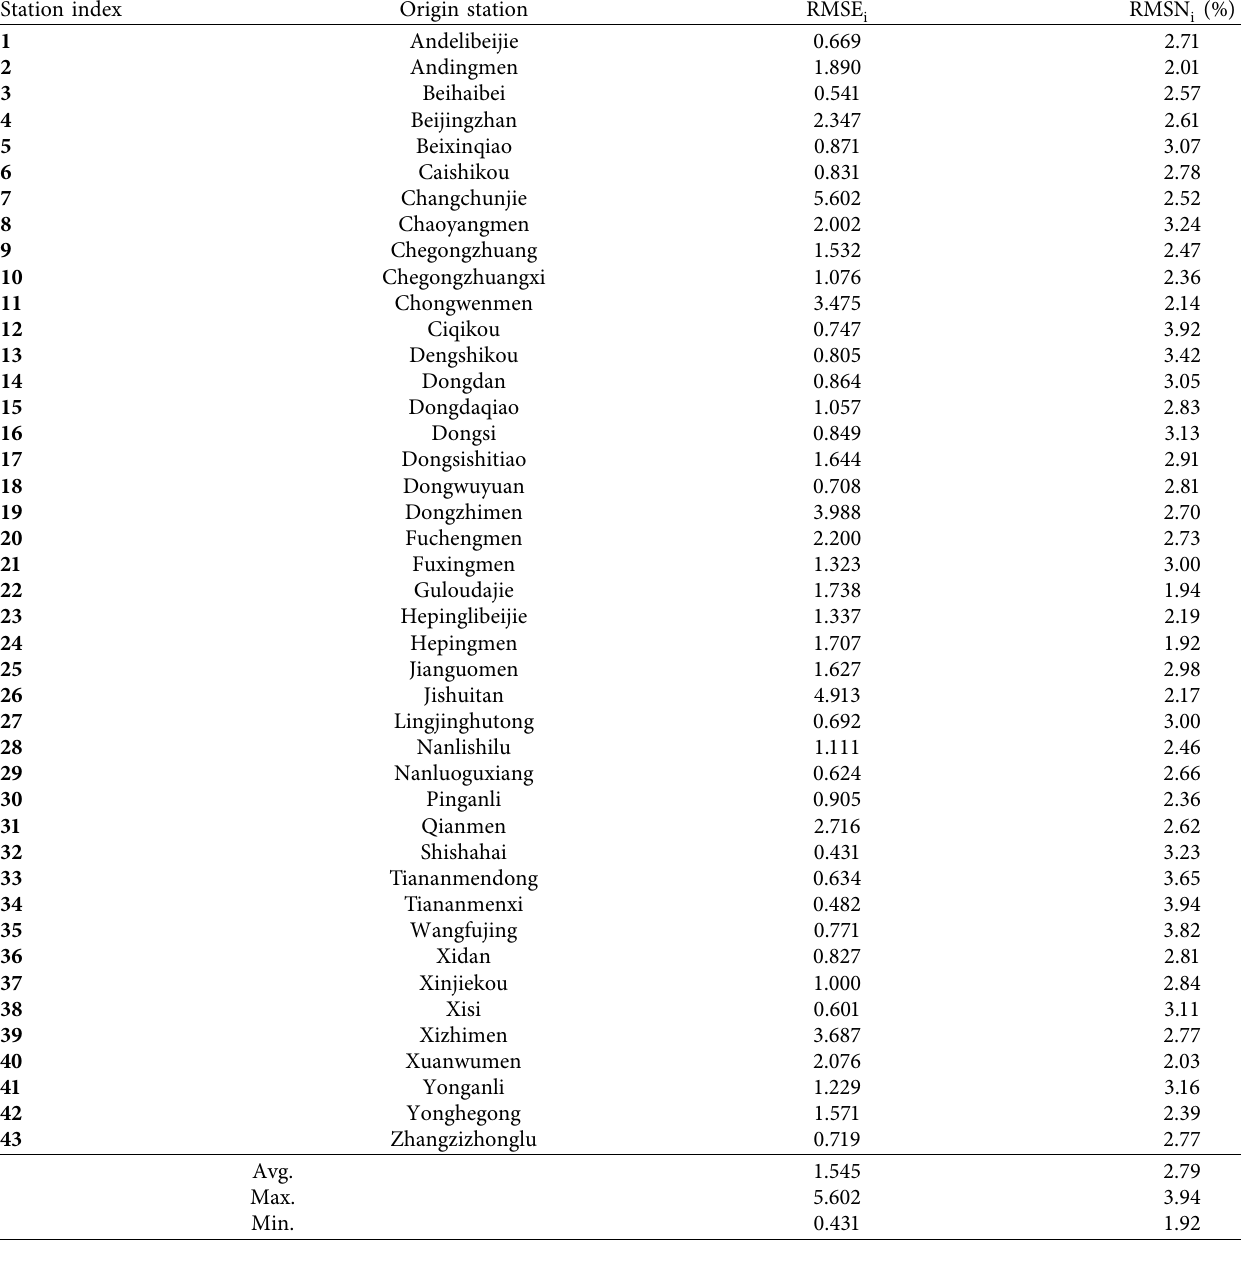
Table 3: RMSE and RMSN of the estimation